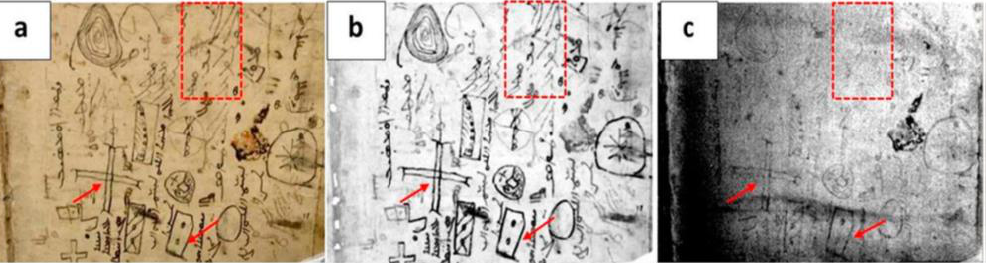
Figure 2. Libro Sacro of the Church Vergine Maria di Qaeaqosh o Baghdide ; ( a ) photograph of the page containing a different kind of inks; ( b ) thermogram, and ( c ) MWIR reflectogram. The arrows indicate the inks containing carbon-based components, while the dashed rectangle marks writing are not more visible, thus revealing the absence of carbon in its composition. (Reprinted with permission from Ref. [38]: Mid-wave Infrared Reflectography and Thermography for the Study of Ancient Books: A Review, Studies in Conservation , N. Orazi, copyright 2020 © The International Institute for Conservation of Historic and Artistic Works, reprinted by permission of Taylor & Francis Ltd (Milton Park, Oxfordshire, UK), http://www.tandfonline.com on behalf of The International Institute for Conservation of Historic and Artistic Works).